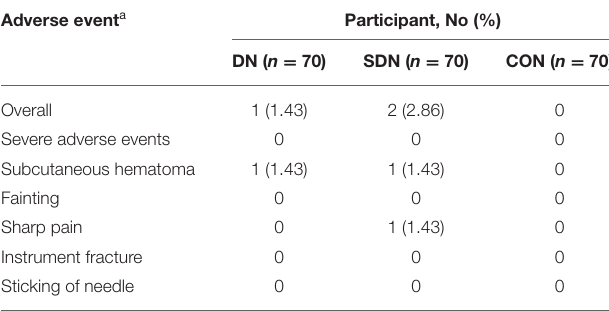
TABLE 10 | Adverse events related to treatment. Adverse event